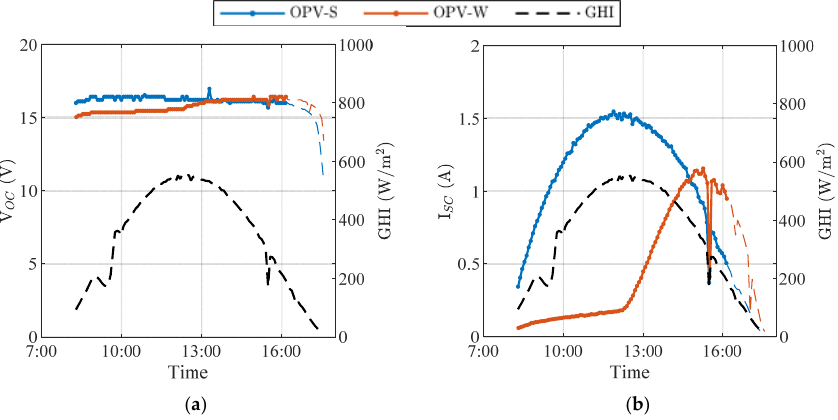
Figure 10. Example of raw data on a sunny day: ( a ) open-circuit voltage, V oc ; ( b ) short-circuit current,